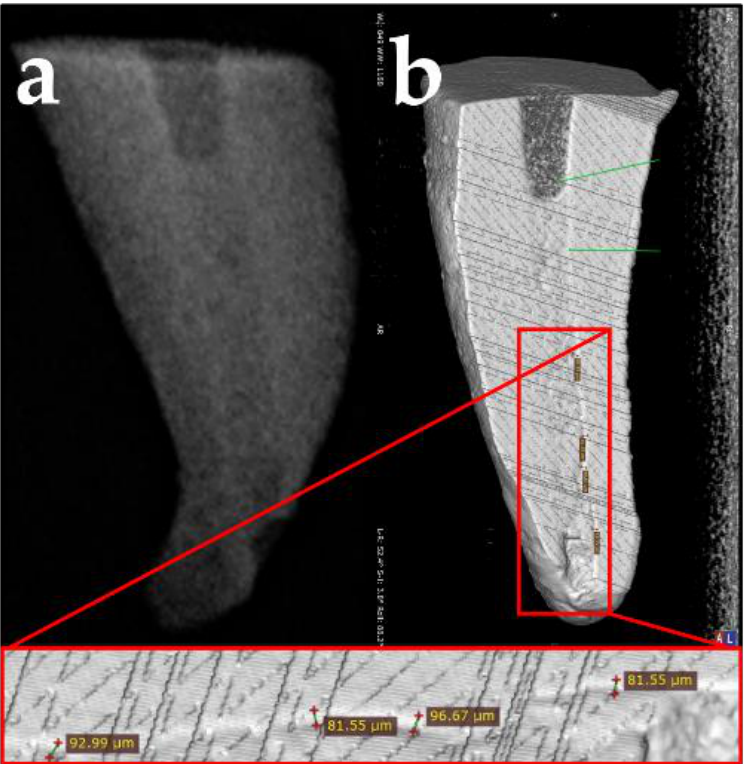
Figure 12. Determination of the sealing quality in root canals. ( a ) X-ray images; ( b ) µCT images of obturated root canals.